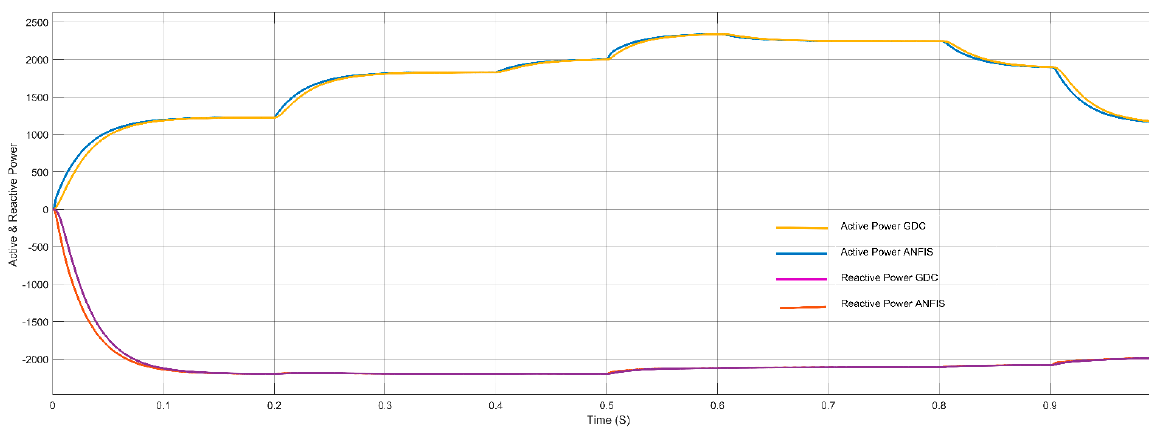
Figure 19. Comparison of Active and Reactive power vs. Time.